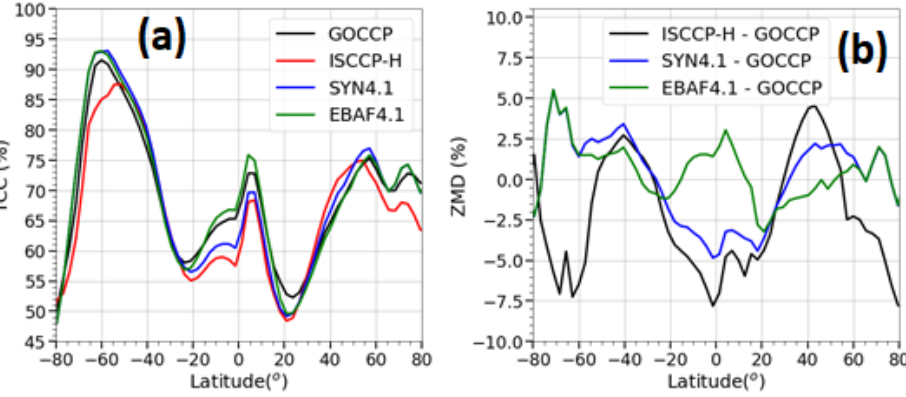
Figure 6. Annually zonally averaged TCC ( a ) and the zonal mean differences (ZMD) ( b